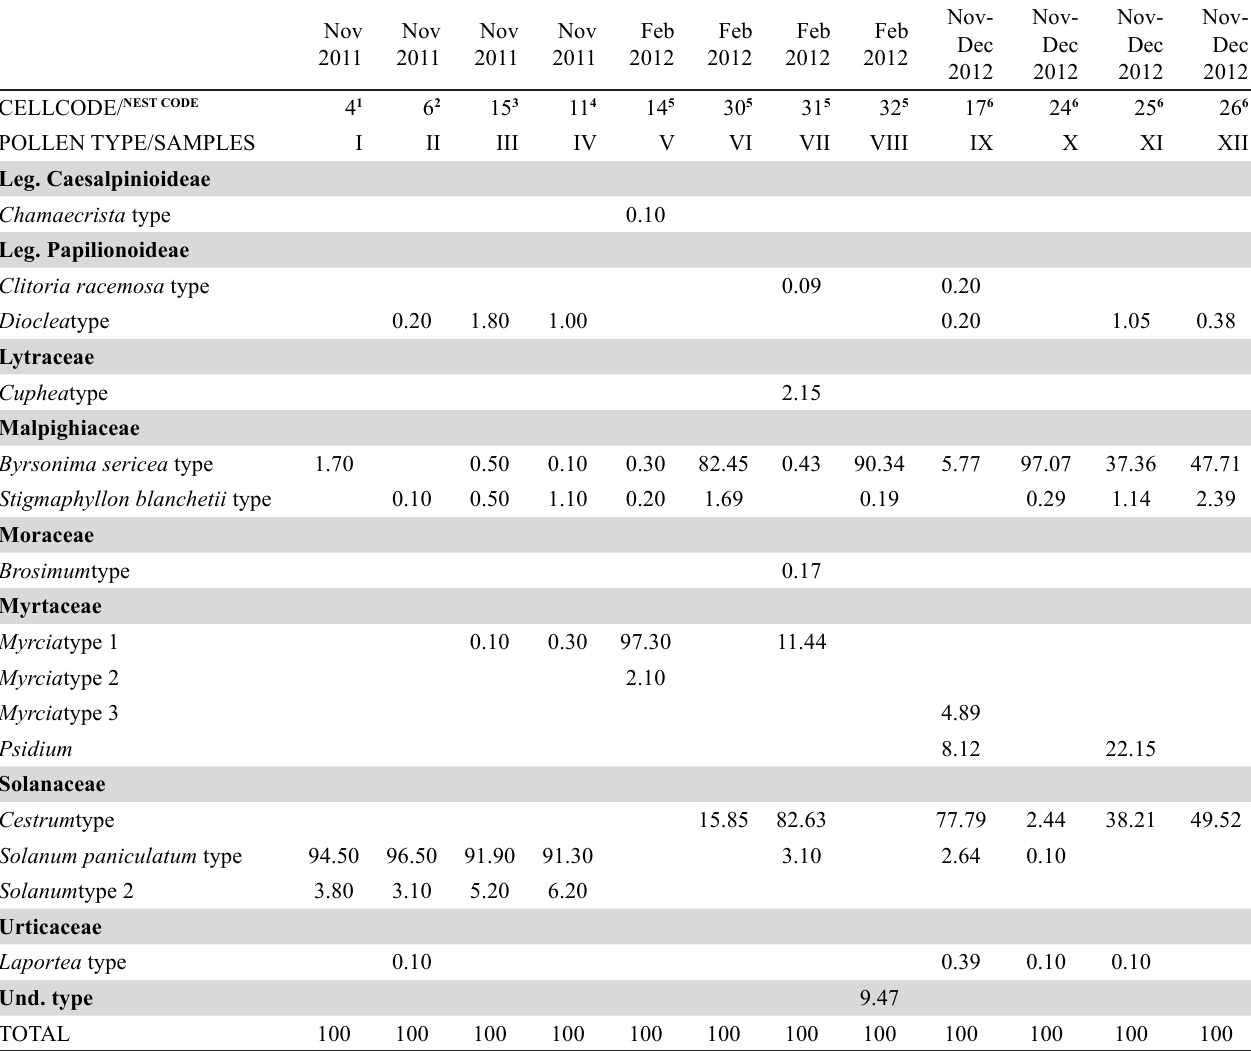
Table 1. Frequency of pollen types (%), recorded in brood cells/nests of Centris (Centris) flavifrons within an urban area in the municipality of João Pessoa, Paraíba State, Brazil. Und=